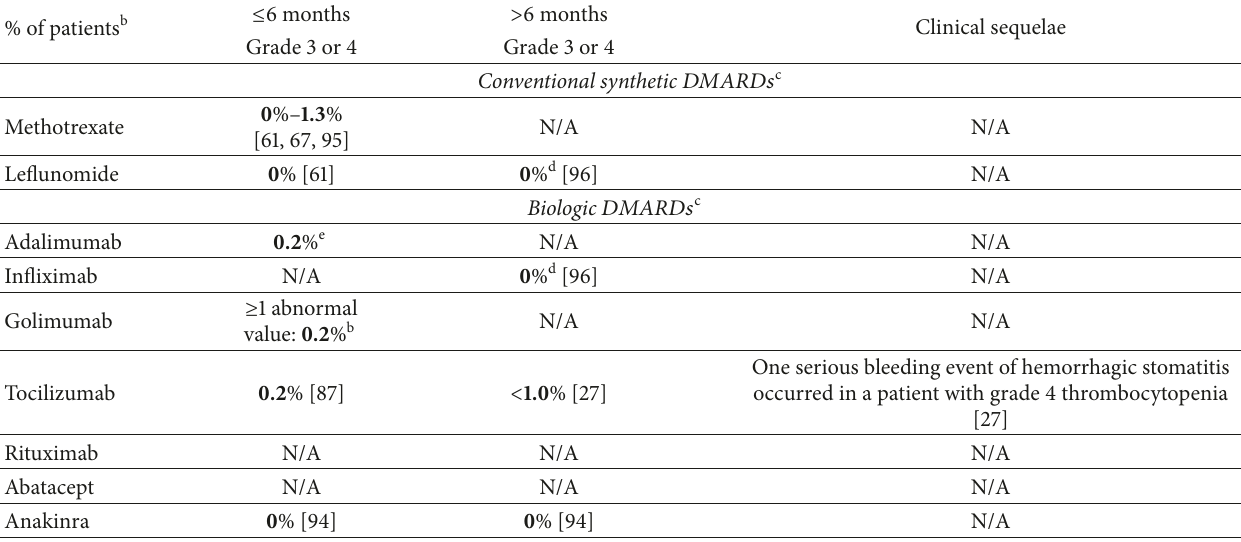
Table 5: Proportions of patients who experienced decreases in platelet counts during RA treatment in clinical trials a . % of patients